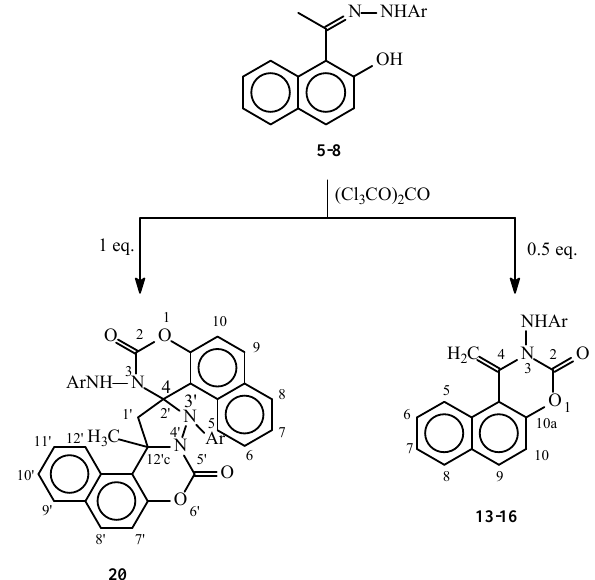
Scheme 3. Reaction of hydrazones 5-8 with